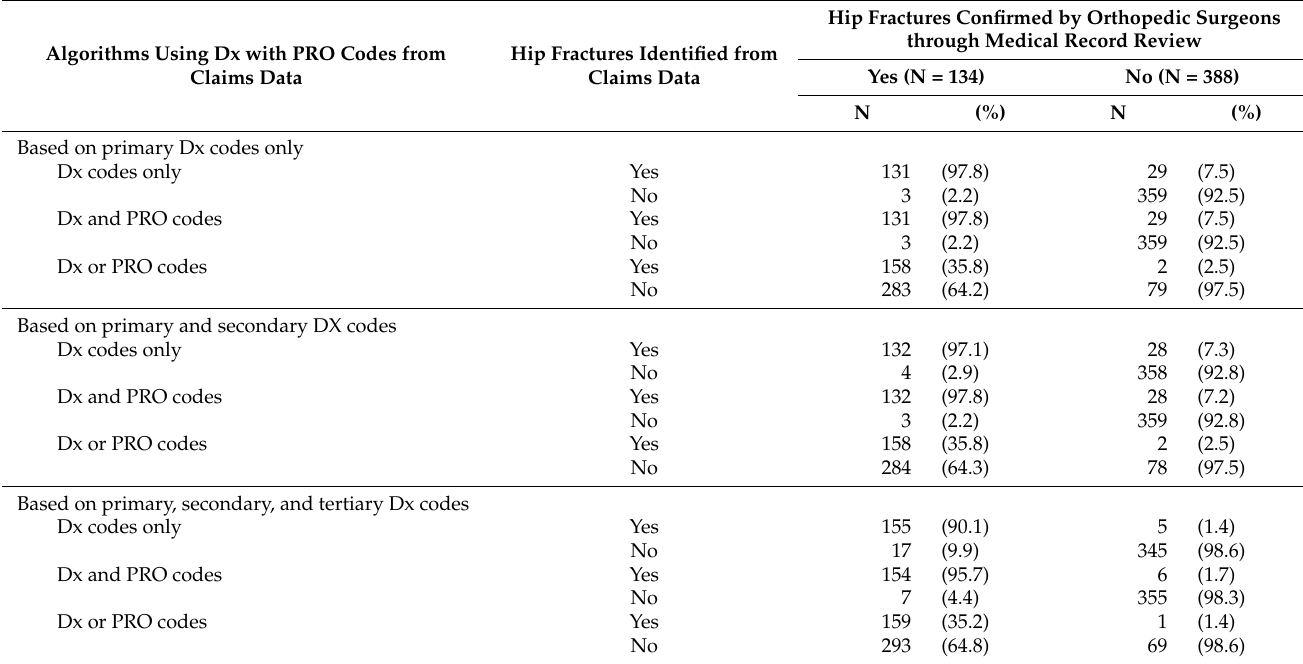
Table 3. Association between algorithms using Dx with PRO codes and orthopedic surgeons in identifying hip